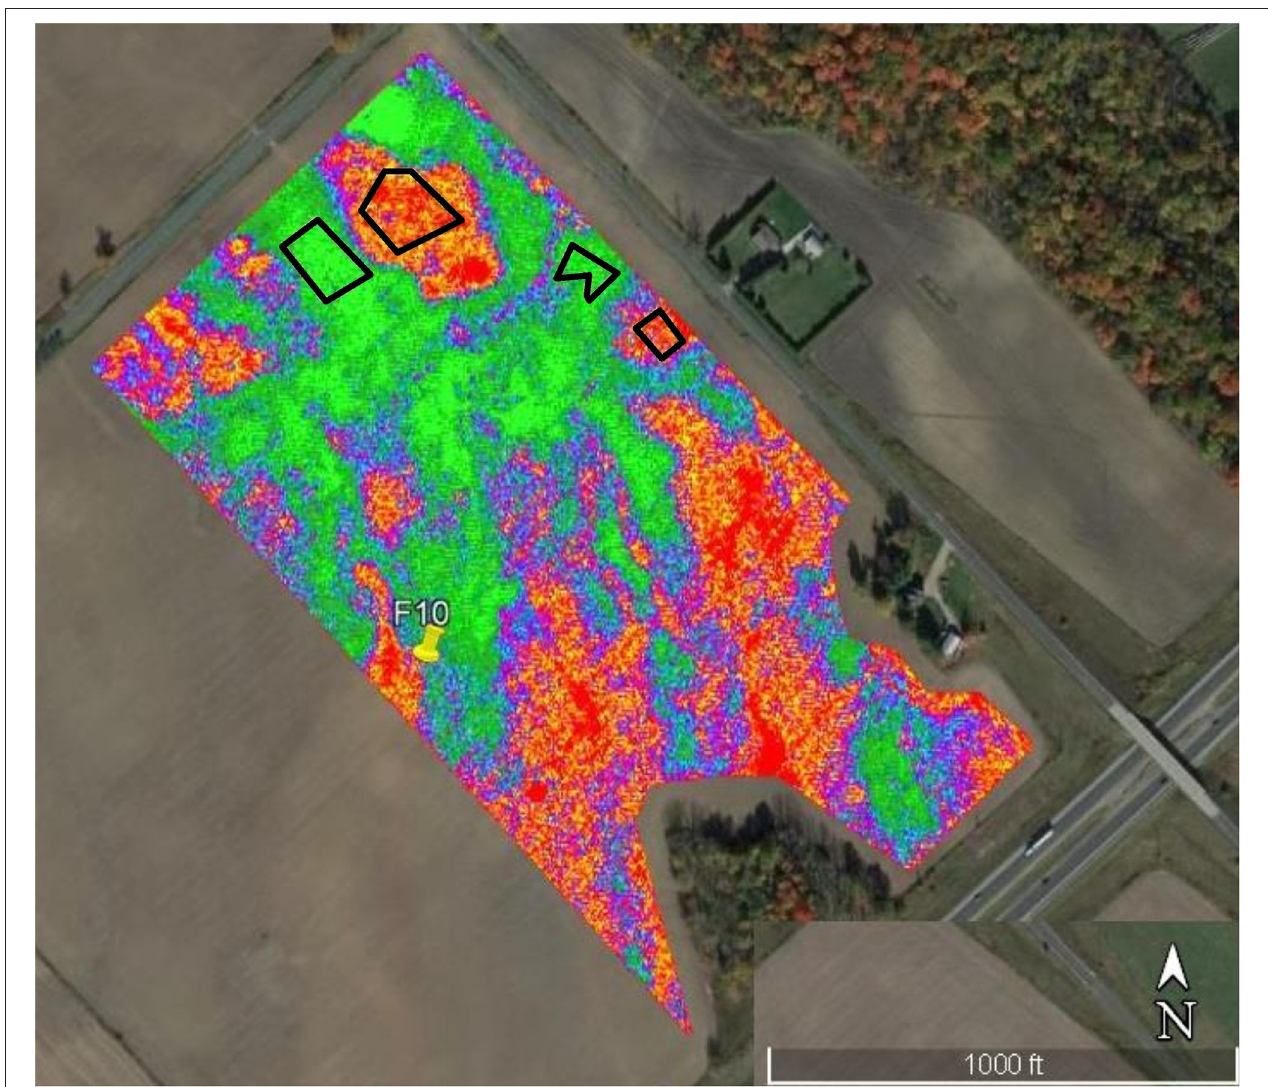
FIGURE 1 | Infra-red aerial image taken by an Unmanned Aerial Vehicle (UAV) of corn at the V10 growth stage in Field 10. Black polygons outline stressed, low yield (red-orange) and healthy, high-yield (green-blue)